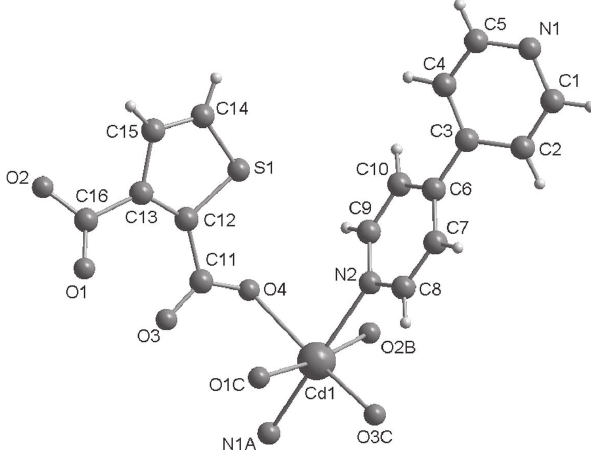
Table 1: Data collection and handling.